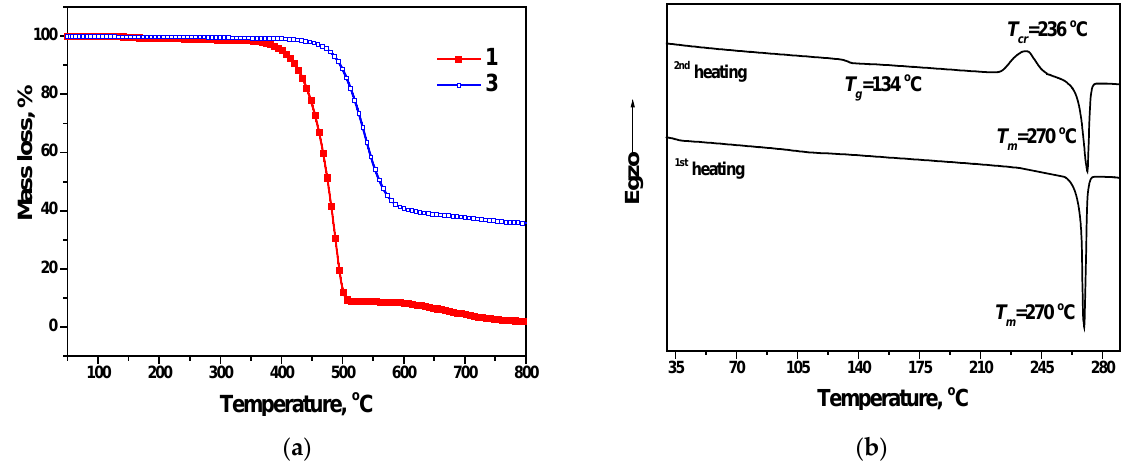
Figure 1. ( a ) TGA curves of compounds 1 and 3 ; ( b ) DSC curves of compound 1